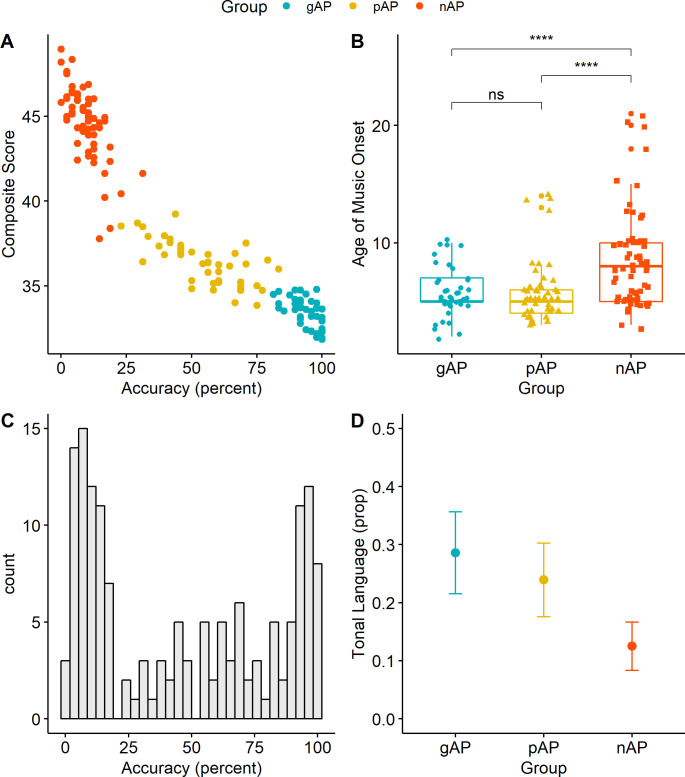
Scatterplot of AP performance across all participants, plotting mean accuracy (the percentage of trials in which a subject answered correctly) on the x-axis and the composite score incorporating MAD and logRT on the y-axis (A). The ages at which individuals in each group began musical instruction are shown, with quartiles for each group (genuine-AP, pseudo-AP, and non-AP), in (B). Distribution of pitch-labeling accuracies are shown in (C). Mean proportions of subjects that report speaking a tonal language are in (D), where error bars represent ± 1 standard error of the mean.